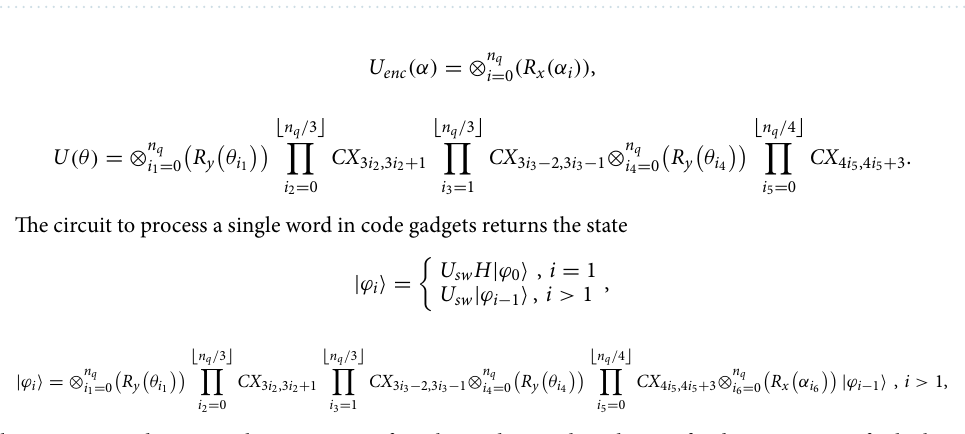
Figure 3. Overview of the quantum deep embedding neural network used in this study. Gate Rx( α ) is the rotation gate generated by Pauli X. According to the algorithm illustrated in this study, the rotation angle is determined using the given classical data x. U(θ) represents a general gate with Ry (the rotation gate generated by Pauli Y) and a controlled X-gate (CNOT-gate). Because the layer is repeated maxlen times, we measure the expectation of Pauli Z based on the first two qubits as the result of the quantum deep embedding neural